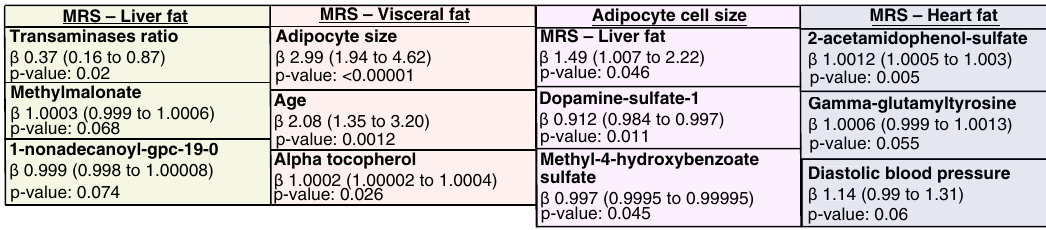
Figure 3. Feature importance for visceral fat and ectopic liver- and heart fat based on extreme gradient boosting models and linear regression for the most important predictors. In Panel ( A )–( B ), relative importance for predictors generated by machine learning are presented. Model diagnostics ( RMSE ) and validation ( R 2 ) are presented next to each prediction model. In Panel ( E ), the most important predictors identified through prediction modeling were included in linear regression